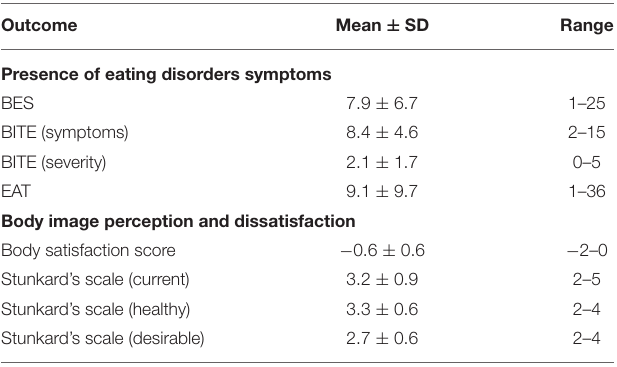
TABLE 2 | Presence of ED